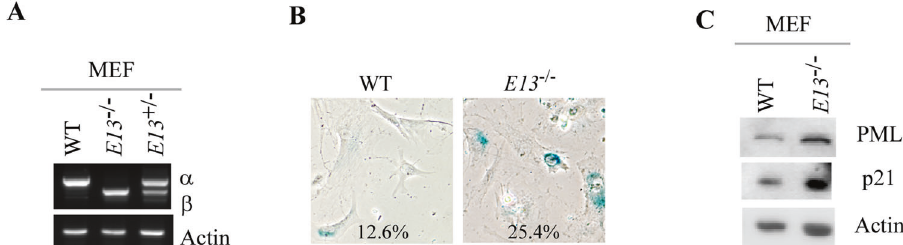
Fig. 2 Loss of E13 promotes cellular senescence in mouse embryonic fi broblasts. A The level of p73 α , p73 β , and actin transcripts was measured in WT, E13 + / − , and E13 − / − MEFs. B WT and E13 − / − MEFs were used for SA- β -gal staining. The percentage of SA- β -gal-positive cells was shown in each panel. C The level of PML, p21 and actin proteins was measured in WT and E13 − / −